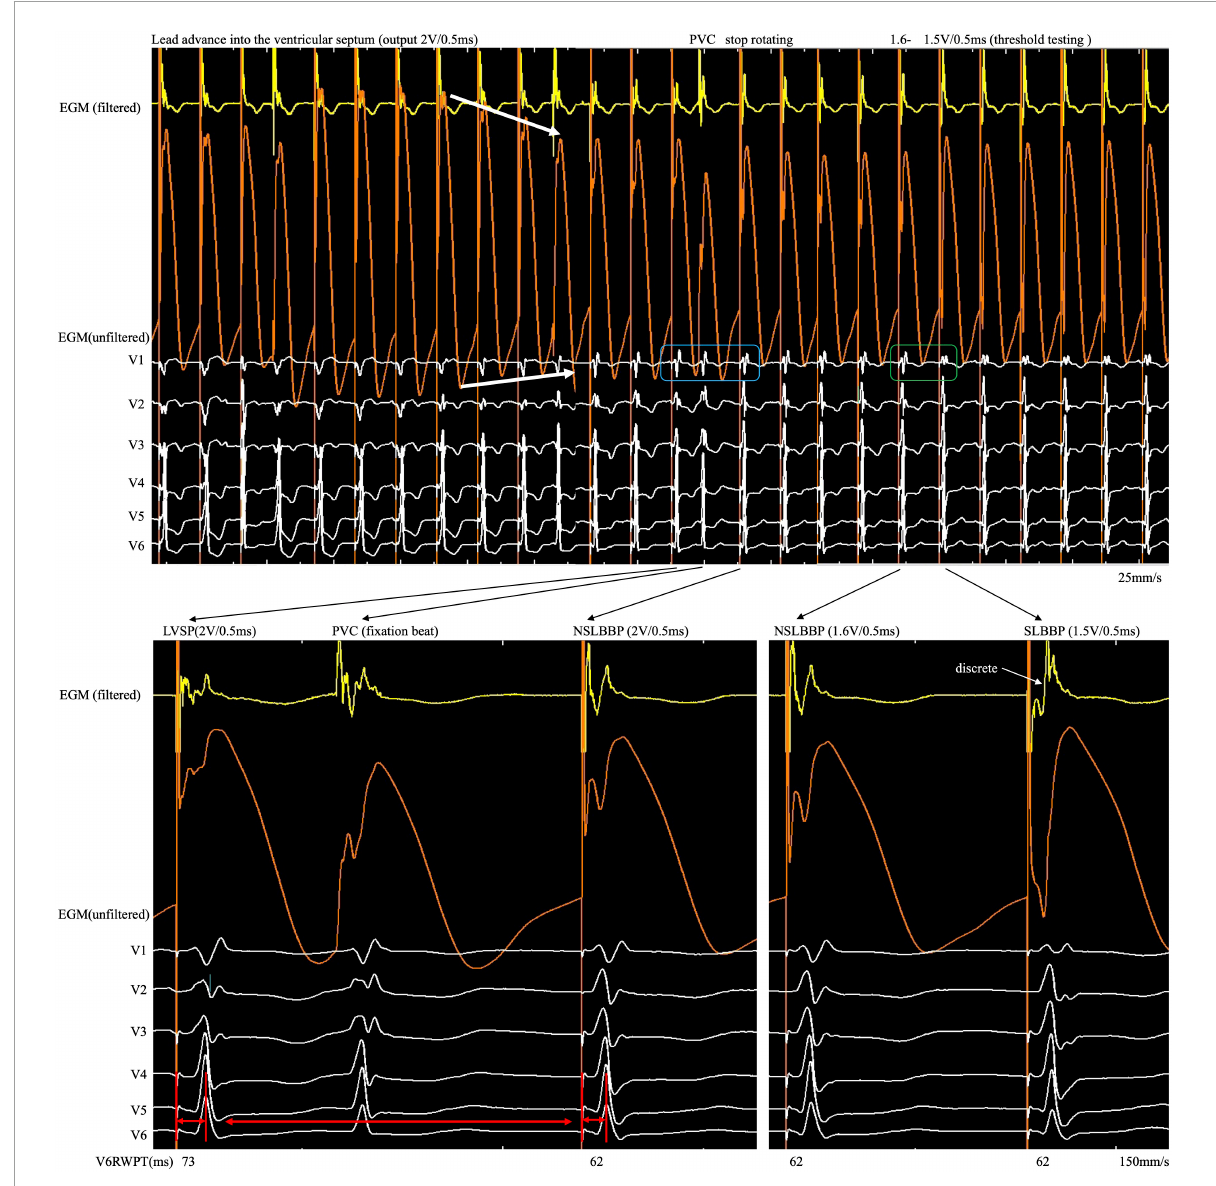
FIGURE2 After the COI amplitude increased to its highest value, the electrode was rotated very slowly to avoid a sudden drop in COI until the LBB area was reached. An abrupt shortening of V6RWPT, discrete EGM and fixation beat were observed. COI, current of injury; LBB, left bundle